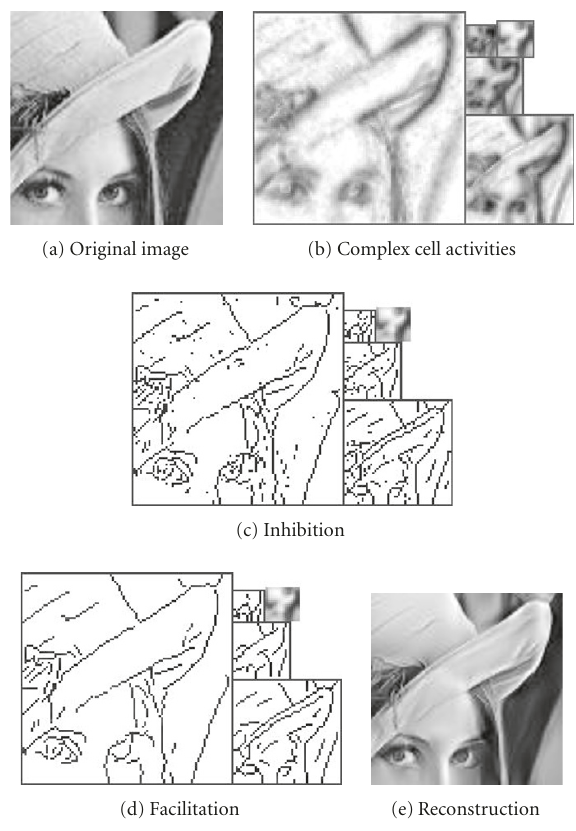
Figure 5: Successive steps modeling V1 architecture as a sparse ap- proximation strategy. (a) 96 × 96 detail of the “Lena” image. (b) Complex cell activities are modeled as the log-Gabor coe ffi cient modulus (Section 2.1). All the orientations are overlaid so that one inset is shown for each scale. The di ff erent scales have di ff erent sizes due to the downsampling applied. From the largest to the smallest the insets correspond respectively to the 2nd, 3rd, 4th, low-pass and 5th scale. The first scale is not represented. (c) Remaining coe ffi - cients after the inhibition step (Section 2.3). (d) The facilitation step (Sections 2.4-2.5) preserves the coe ffi cients arranged in su ffi ciently long chains and having parent coe ffi cients within coarser scales. The remaining cells conform the sparse approximation of the image. It is composed by a subdictionary including the most salient multiscale edges and the low-pass version of the image. (e) The gain control step (Section 2.6) assigns an amplitude to the subdictionary edges. Then the inverse log-Gabor wavelet transform reconstructs an ap- proximation of the